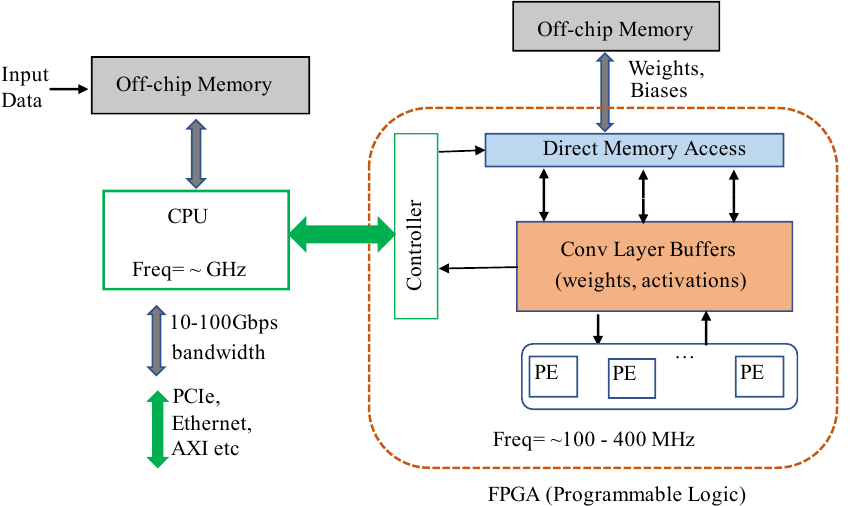
Figure 2. Typical FPGA-based Inference